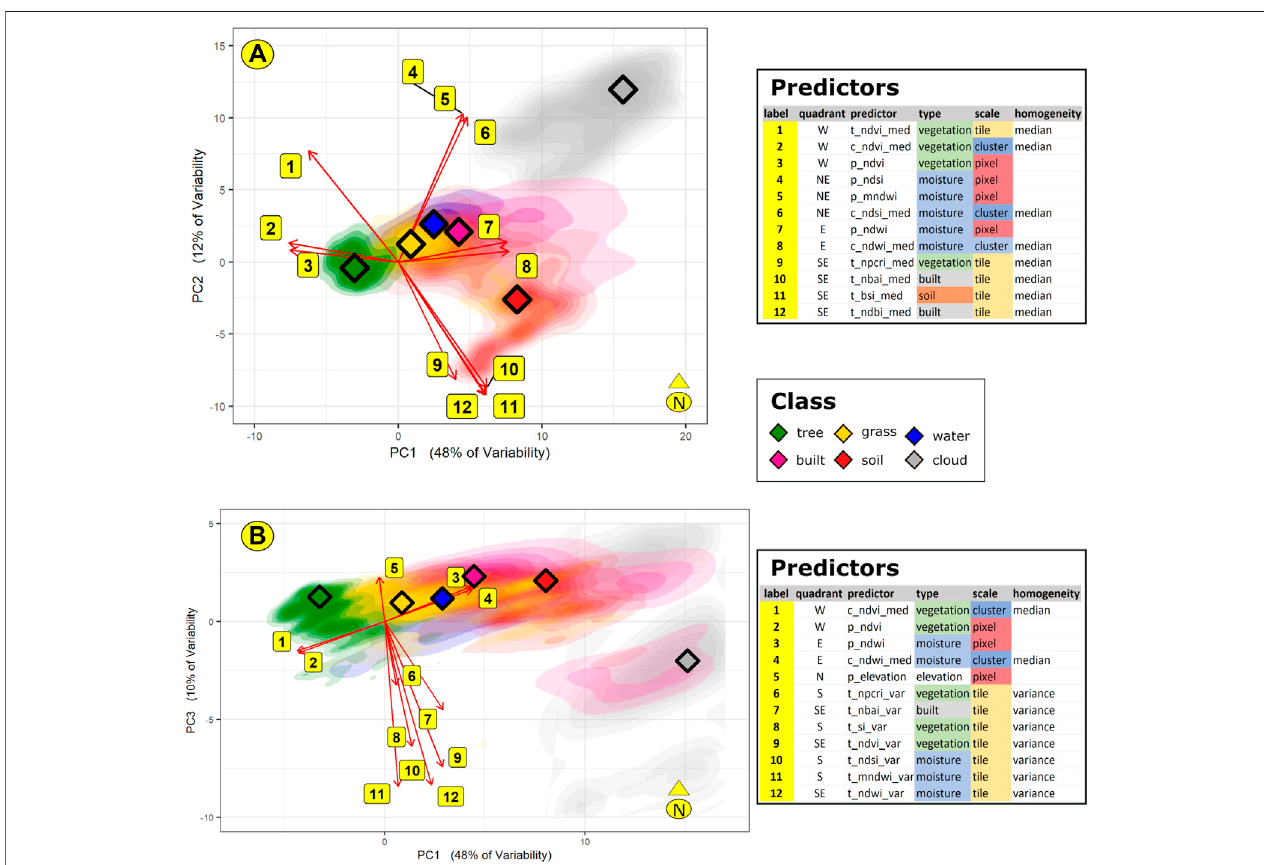
FIGURE 11 | We conducted a PCA on our annotated dataset. The fi rst three dimensions (PC1, PC2, and PC3) explain 70% of the data variability. Individual PCA scores are shown above as differently colored density clouds, with the highest density points for each class shown as diamonds. The Random Forest ’ s high accuracy scores for cloud and tree conform to the observation that their PCA scores cluster distinctly at the east and west quadrants of the PCA. Contrariwise, the individual scores for the other classes merge closely together near the point of origin. PC1 ’ s west and east quadrants are dominated by loadings related to vegetation and moisture, respectively. Both PC2 ’ s and PC3 ’ s southern quadrant is dominated by tile-level measures of homogeneity — median and variance for PC2 and PC3, respectively.